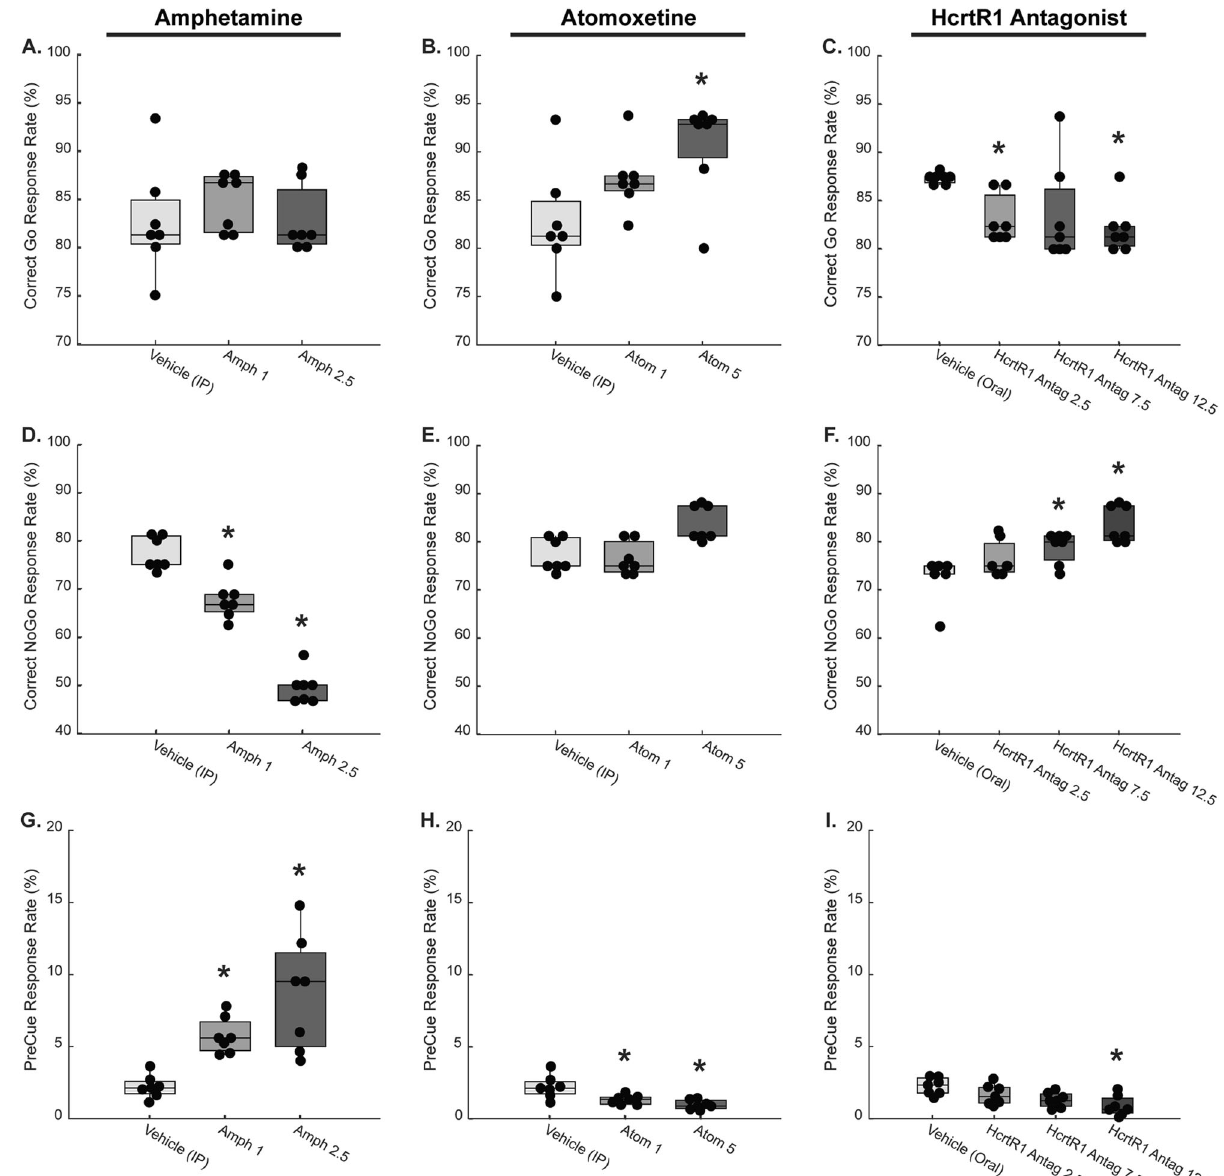
Fig. 3 Pharmacological Manipulation of Go/NoGo Performance. Amphetamine decreases correct NoGo response rate ( D ) and increases PreCue response rate ( G ), but does not alter correct Go response rate ( A ). In contrast, atomoxetine increases correct Go response rate ( B ) and decreases PreCue response rate ( H ), but does not alter correct NoGo response rate ( E ). Selective HcrtR1 antagonism decreases correct Go response rate ( C ) and PreCue response rate ( I ) and increases correct NoGo response rate ( F ). Vehicle data are shared between amphetamine and atomoxetine groups (delivered I.P.), whereas HcrtR1 antagonist data are compared to vehicle delivered in the same modality (oral gavage). *denotes difference between from vehicle treatment (Bonferroni ’ s test, p < 0.05). Box plots indicate averages and standard deviation. Whiskers span maxima and minima